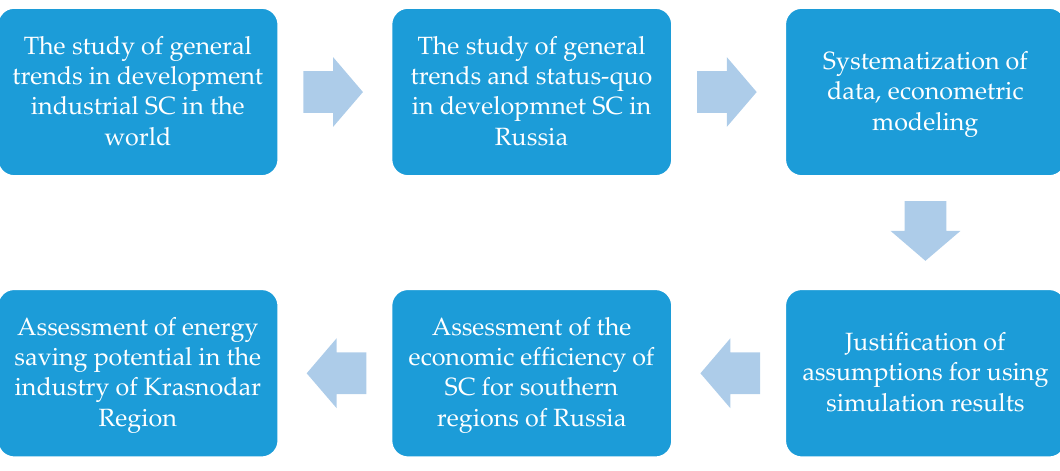
Figure 2. The general algorithm of the study.